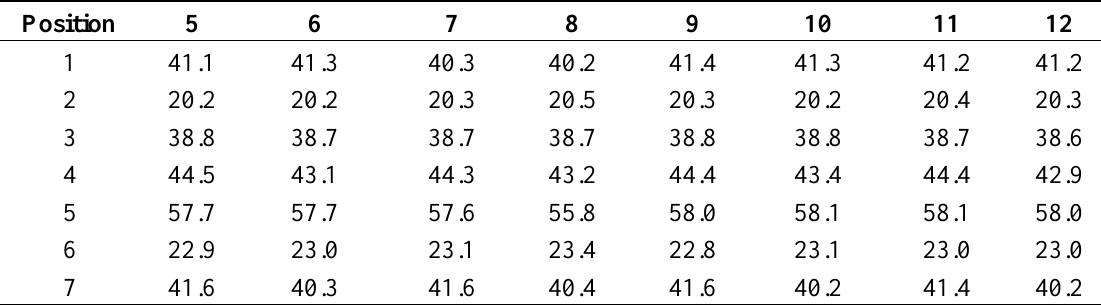
Table 8. 13 C NMR chemical shifts values for reduced compounds 5 – 12 recorded